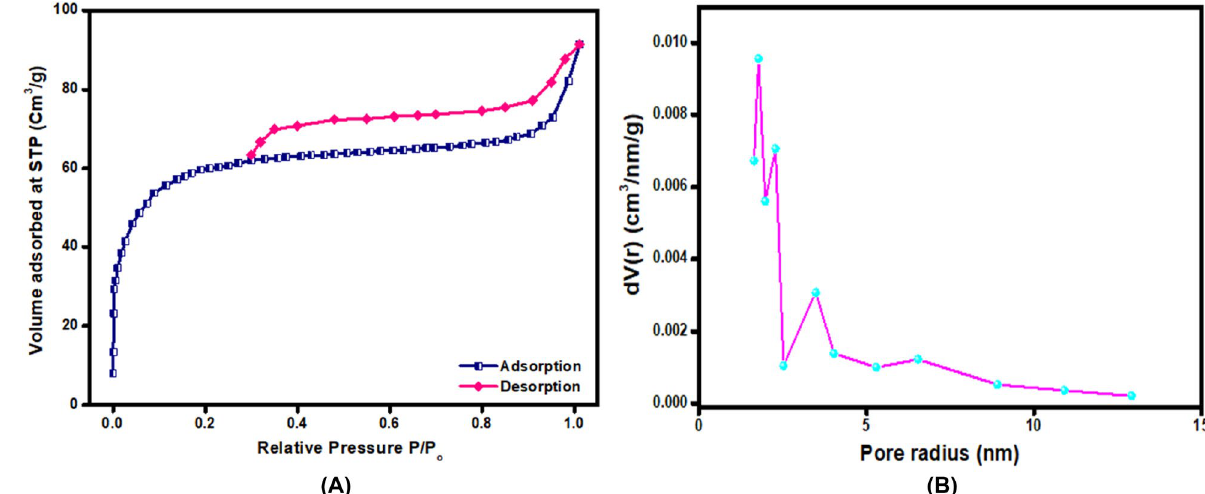
Figure 3. ( A ) N2 adsorption/desorption isotherm and ( B ) pore size distribution of K@AM-CTS composite beads.